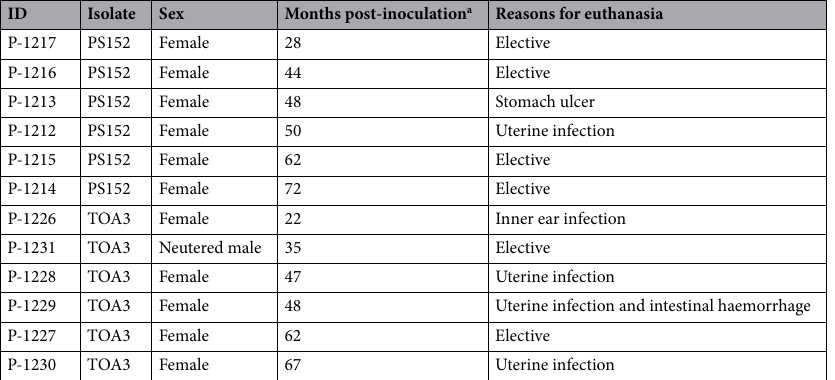
Table 1. Inoculation of pigs with atypical scrapie isolates. a Pigs were euthanized without showing clinical signs of